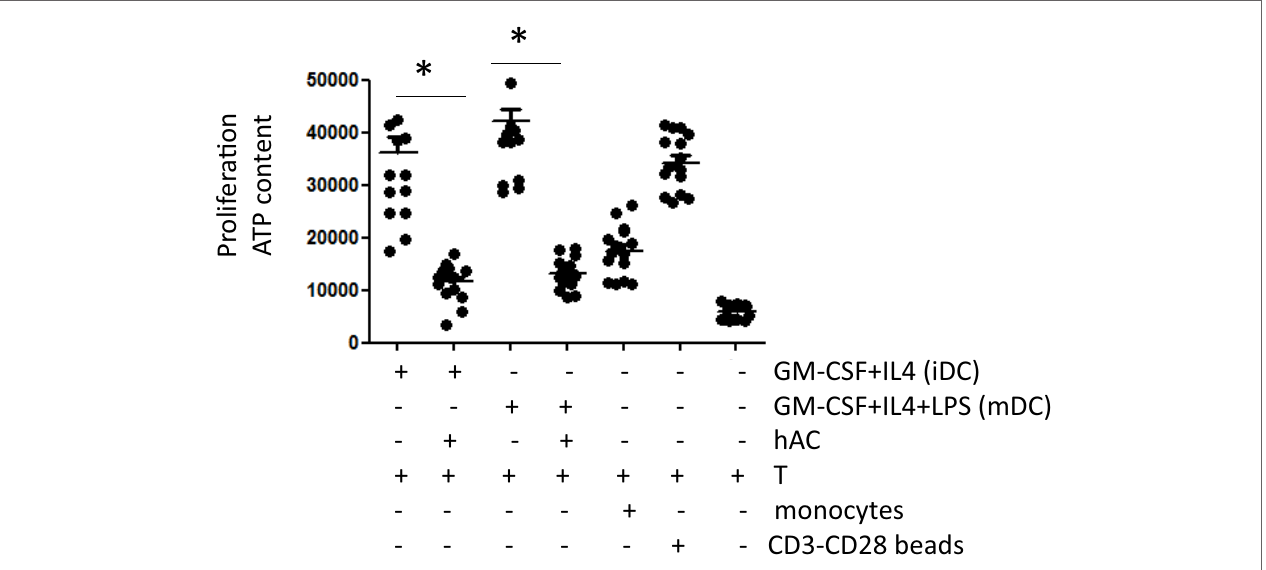
FigUre 5 | Mo-derived cells harvested from co-cultures with hac do not trigger the allo-response of T cells . Cells derived from culture of peripheral blood Mo with GM-CSF + IL-4 (6 days, indicated as iDC) or GM-CSF + IL-4 + LPS (6 days of GM-CSF + IL-4 + 2 days of LPS, indicated as mDC) without or with hAC were harvested, extensively washed and put again in culture with allo-T cells purified from unrelated donors (T) at the T:antigen-presenting cell ratio of 10:1. The effect of unstimulated Mo [as the minimal triggering of proliferation of T cells and of CD3–CD28 mAb-coated beads (CD3-CD28 coated beads)] as the maximal T cell proliferation is shown for comparison. Results are expressed as counts of luminescence evaluating the ATP content in proliferating cell cultures and they are the mean ± SD of eight independent experiments using six different hAC preparations and eight healthy unrelated T cell donors. * p <